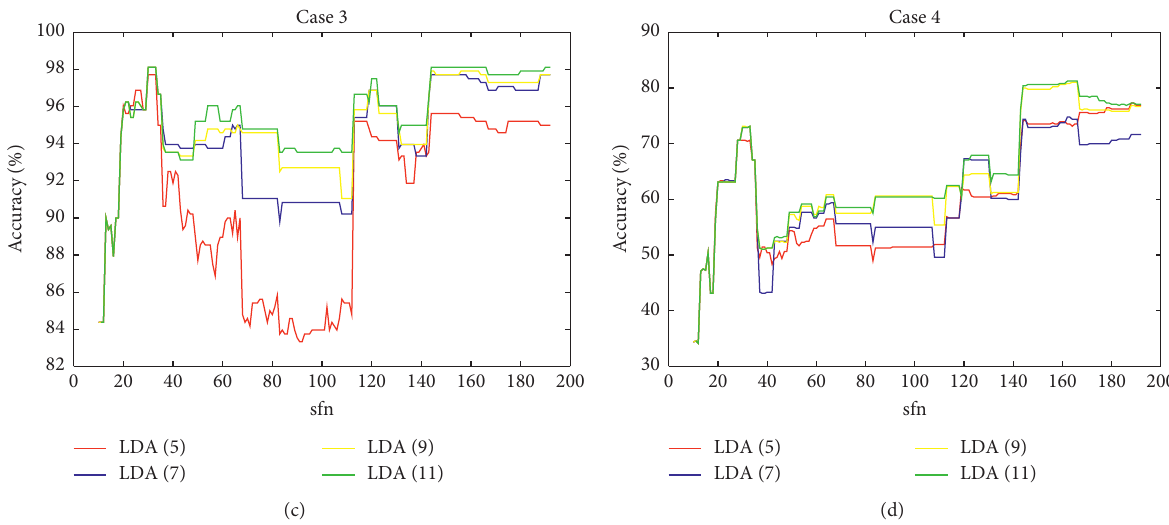
Figure 11: The curve representation of diagnosis results obtained by the OFS-TSFRS-LDA-SVM model using WPT with different di- mension sizes for LDA. The LDA (5) represents that the number of dimension size is 5.